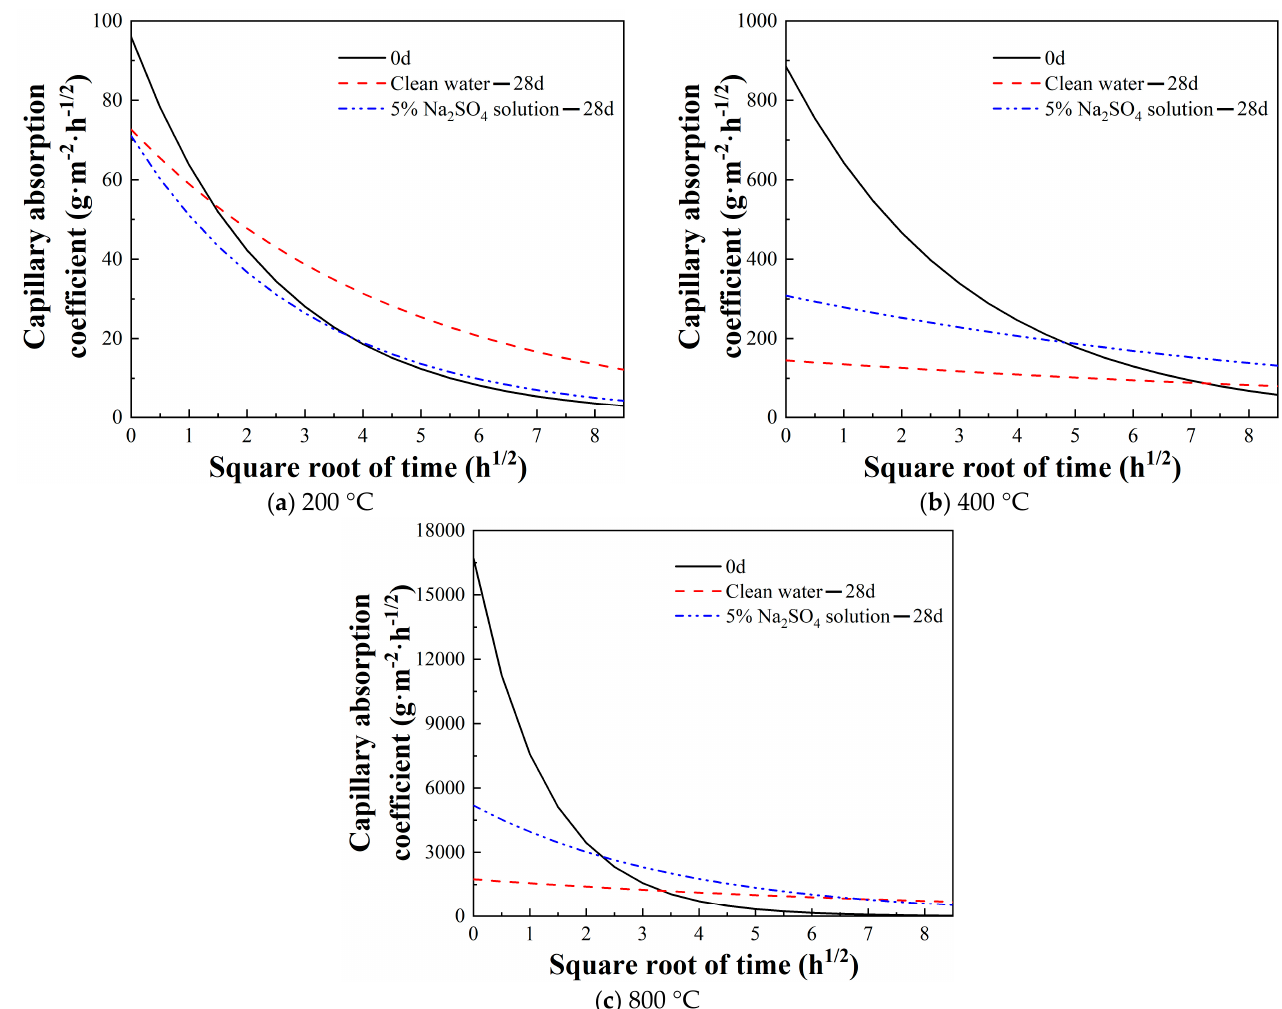
Figure 18. Capillary water absorption coefficient curves after exposure to high temperatures and self-healing.